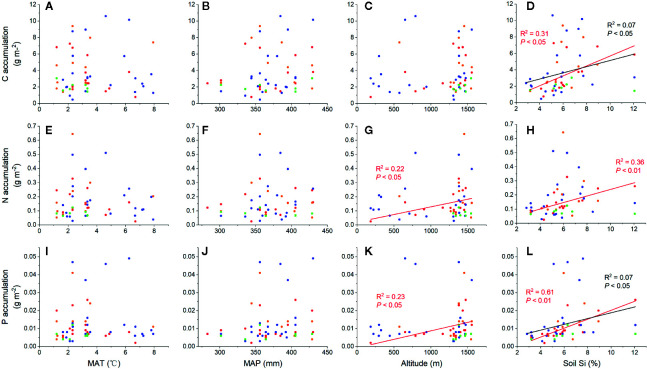
Relationships between environmental factors (MAT, MAP, altitude, and soil noncrystalline Si) and C, N, and P accumulation. The red dots, lines, and text represent L. chinensis, blue represents C. squarrosa, green represents A. mongolicum, and yellow represents S. krylovii. The black dots, lines, and text represent all grass samples. The effects of environmental factors to C accumulation (A–D), N accumulation (E–H) and P accumulation (I–L).